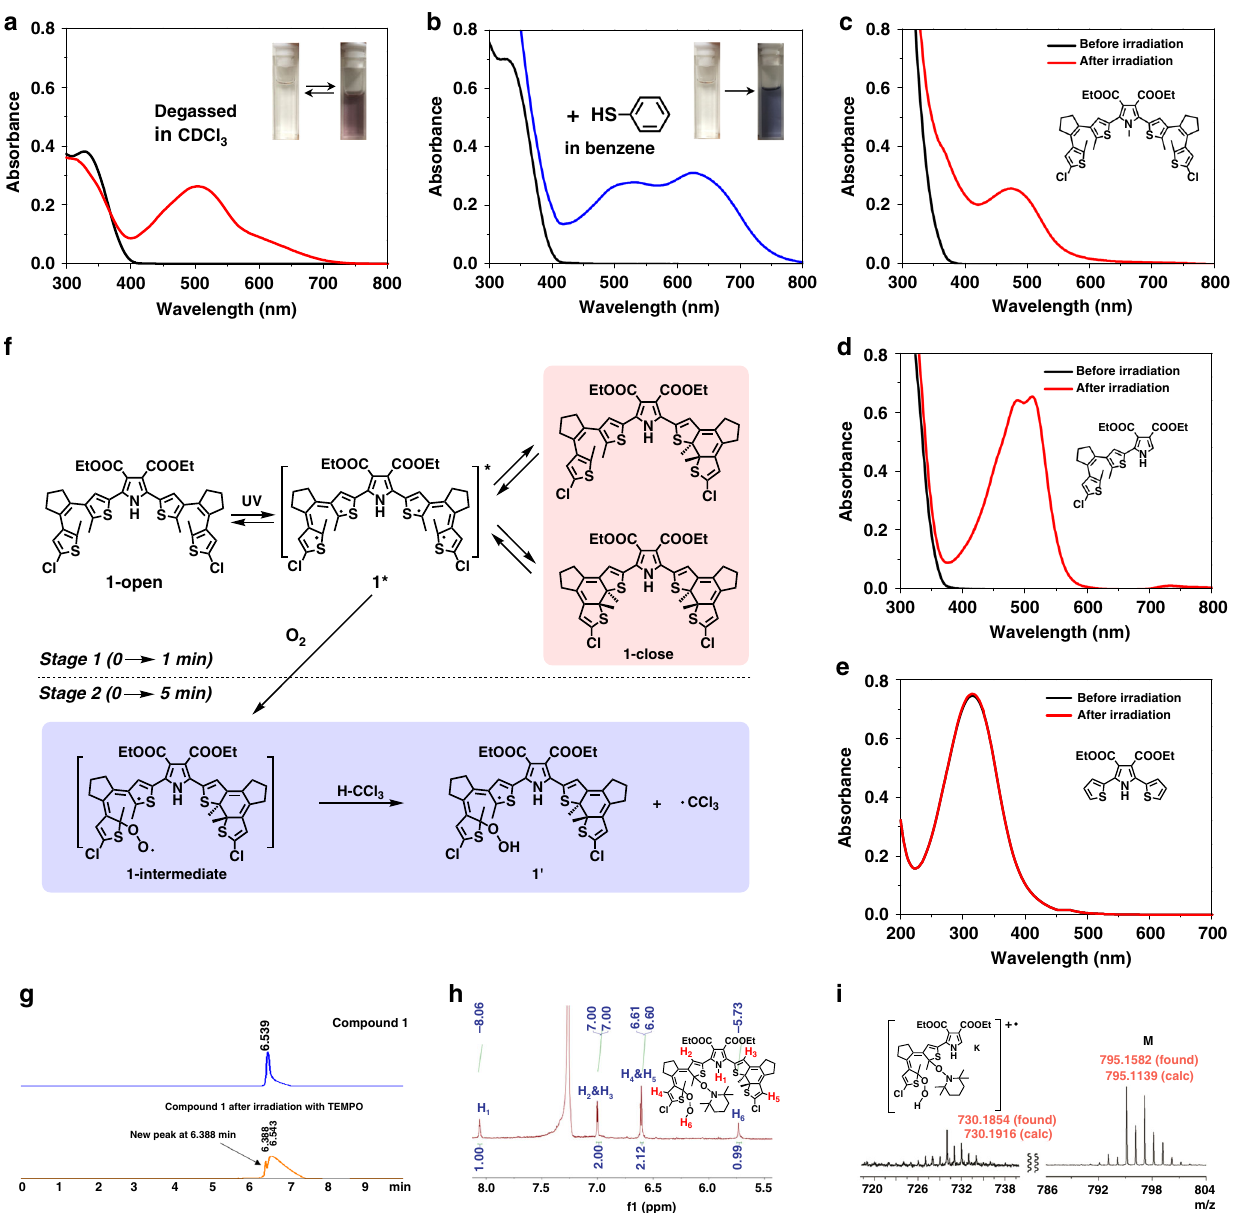
Fig. 4 Mechanism study on the radical species. a UV – vis absorption spectral changes of compound 1 (1.0 × 10 − 5 M) upon irradiation with 365 nm light for 5 min in degassed CHCl 3 . Inset: the corresponding solution color change. b UV – vis absorption spectral changes of compound 1 (1.0 × 10 − 5 M) with 10 equiv. of thiophenol in benzene upon irradiation with 365 nm light for 5 min at 25 °C. Inset: the corresponding photographic images upon irradiation with 365 nm light for 5 min. UV – vis absorption spectral changes of compounds 2 ( c ), 3 ( d ), 4 ( e ) in CHCl 3 (1.0 × 10 − 5 M) upon irradiation with 365 nm light. f A proposed radical generation process in molecule 1. g HPLC spectra of compound 1 (above) and compound 1 after irradiation with TEMPO (below) at 25 °C under following conditions: Agilent C18 column, acetonitrile-water (6:4, v/v) as mobile phase, the detection wavelength of 254 nm. h Partial 1 H